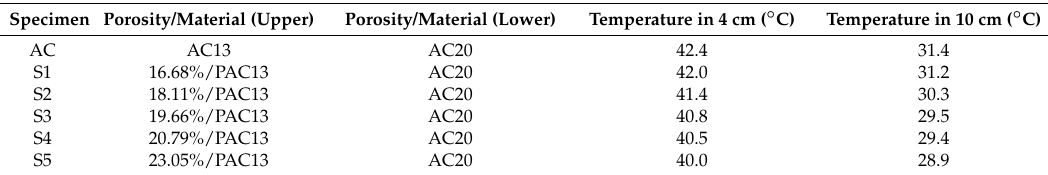
Table 11. Temperature in the specimens.